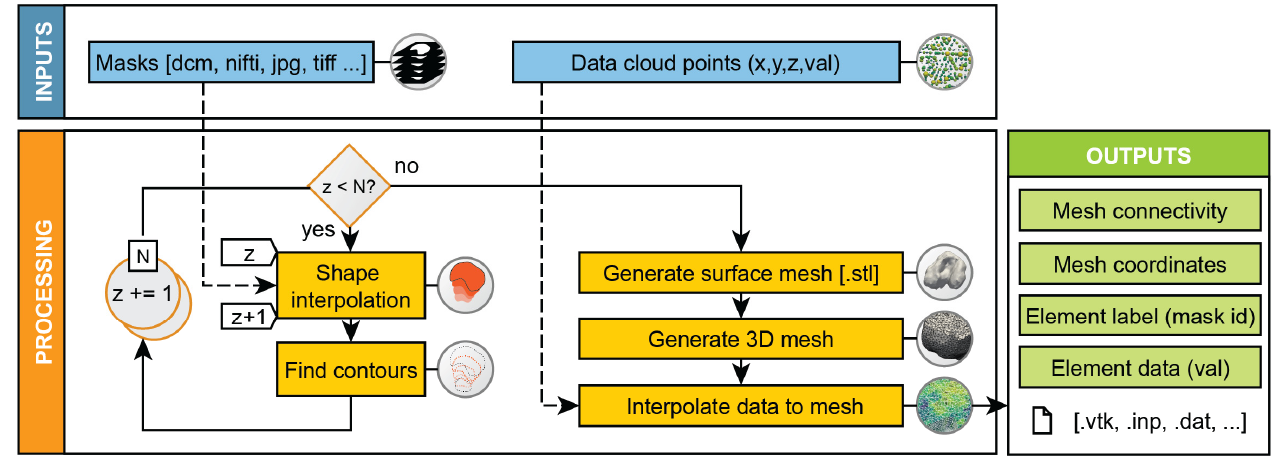
Figure 1. The im2mesh workflow. Image files of multiple formats containing the segmentation masks are accepted as input for the mesh generation. For every pair of layers, starting from the bottom, shapes are interpolated using any number of intermediate positions. Afterwards, the contours of these shapes are computed and stored for later stages. When the interpolation is complete, a surface mesh with the desired number of faces is created (.stl) and further processed to obtain a volumetric 3D mesh in which scalar data is automatically interpolated if available (optional). Useful information (e.g., element labels, connectivity, coordinates, etc.) and already formatted mesh files are exported for further analysis.